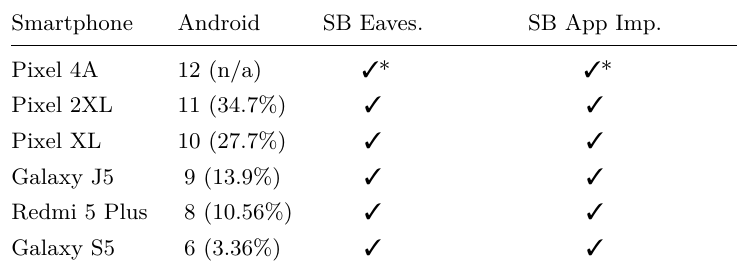
Table 5: Evaluation results for SB attacks against the latest six Android versions. All attacks were tested using a MB 4 as a tracker. The first column shows the smartphone model, the second one the Android version and its market share according to [Sta21]. and fourth columns show that all Android versions we test are vulnerable to SB attacks Android